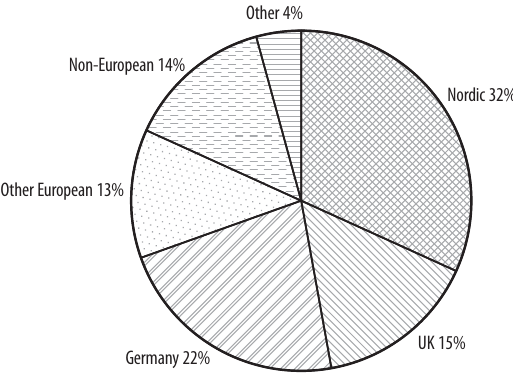
Figure 1. International investors in Finnish property markets,